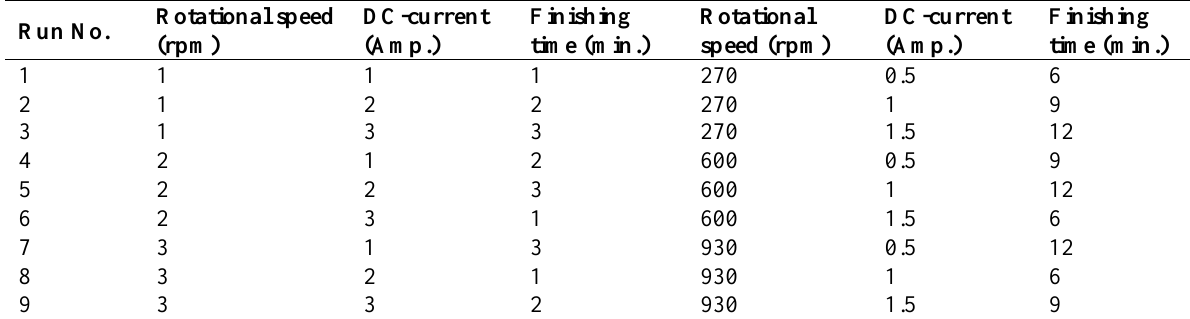
Coded and real MAF parameter of L9 array Run